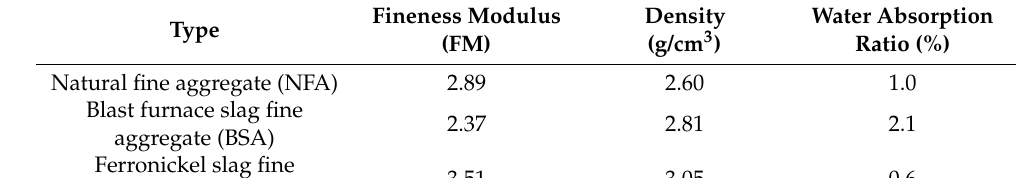
Table 2. Physical properties of fine aggregates.